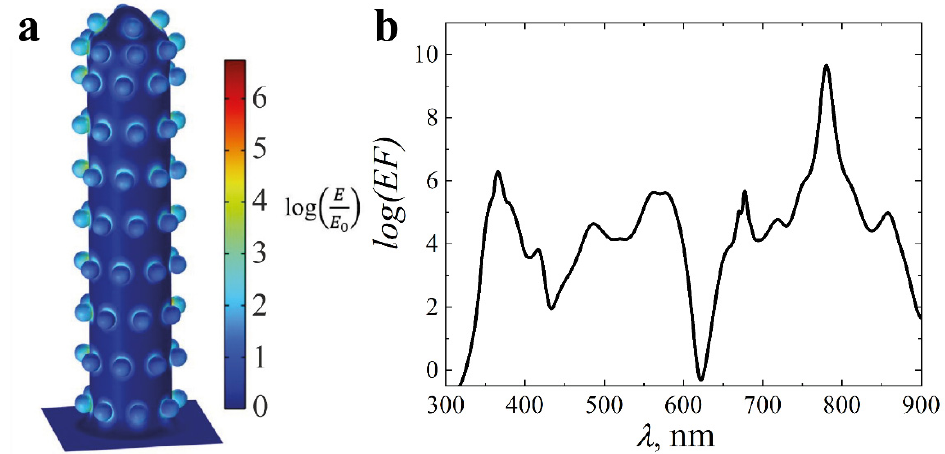
Figure 8. ( a ) Electromagnetic field enhancement distribution for nanowires with Ag; ( b ) calculated enhancement factor of the nanowire with AgNPs as a function of wavelength.